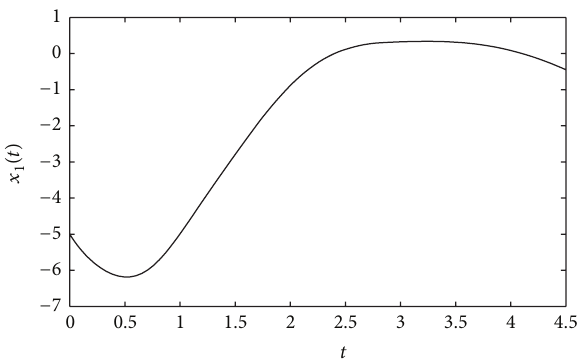
Figure 6: Optimal state under the optimal control.